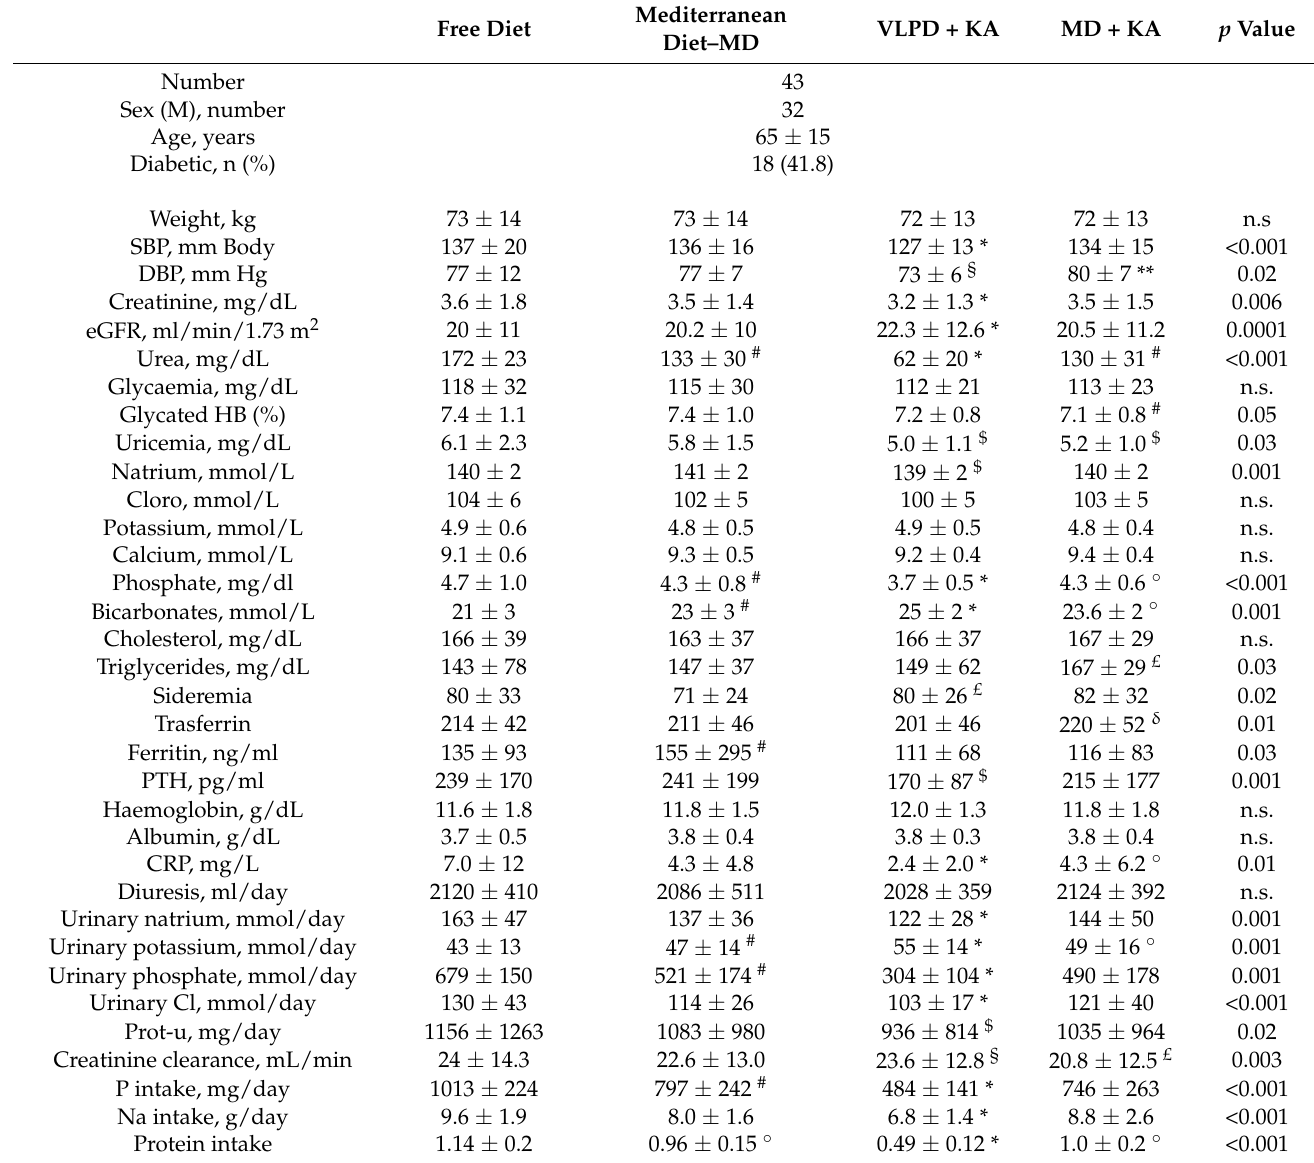
Table 2. Anthropometric, biochemical, clinical data of patients according to each nutritional